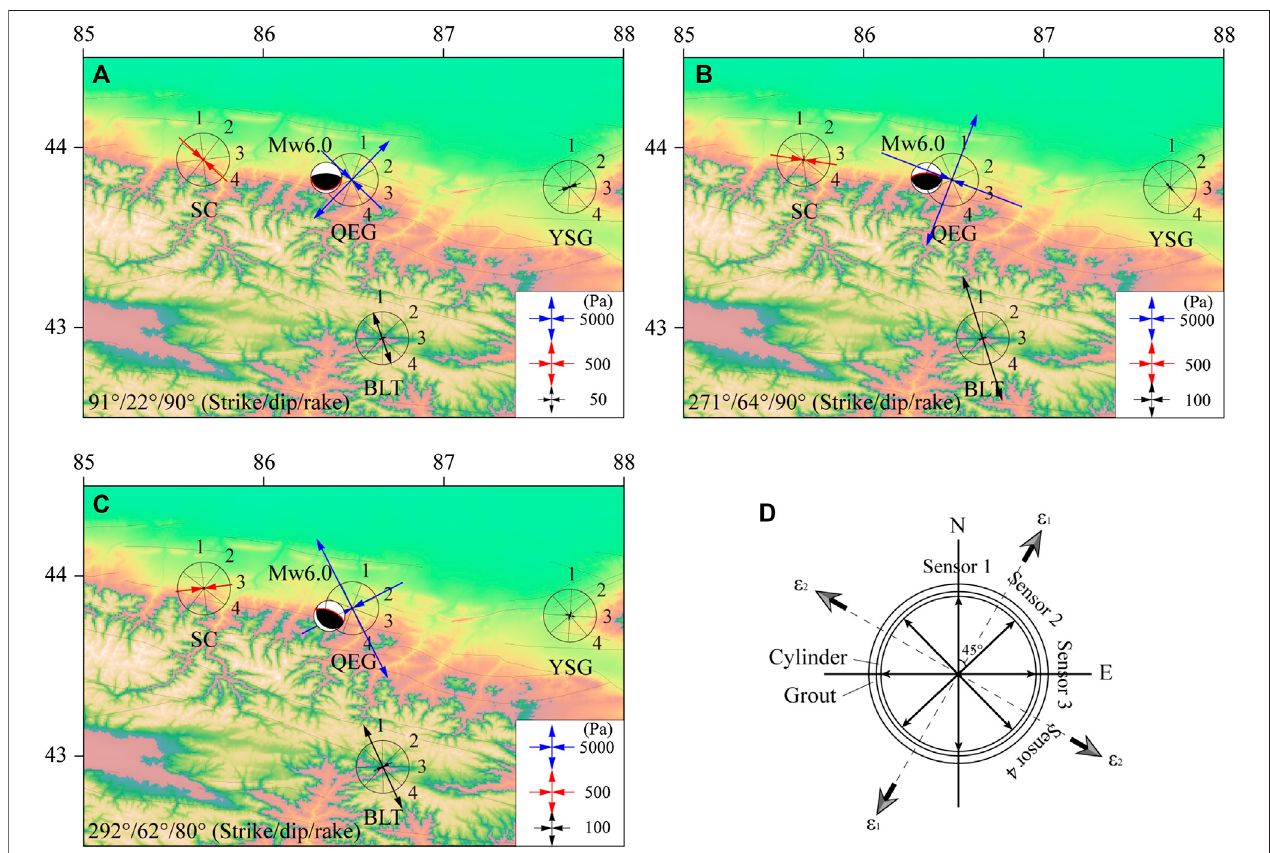
FIGURE 4 | Coseismic principal stress fi elds for the different sets of source parameters in (A) model 1, (B) model 2, and (C) model 3; (D) Schematic diagram of a standard borehole strainmeter, ε 1 and ε 2 represent the maximum and minimum principal strains, respectively. The red line in the beach ball denotes the fault plane.